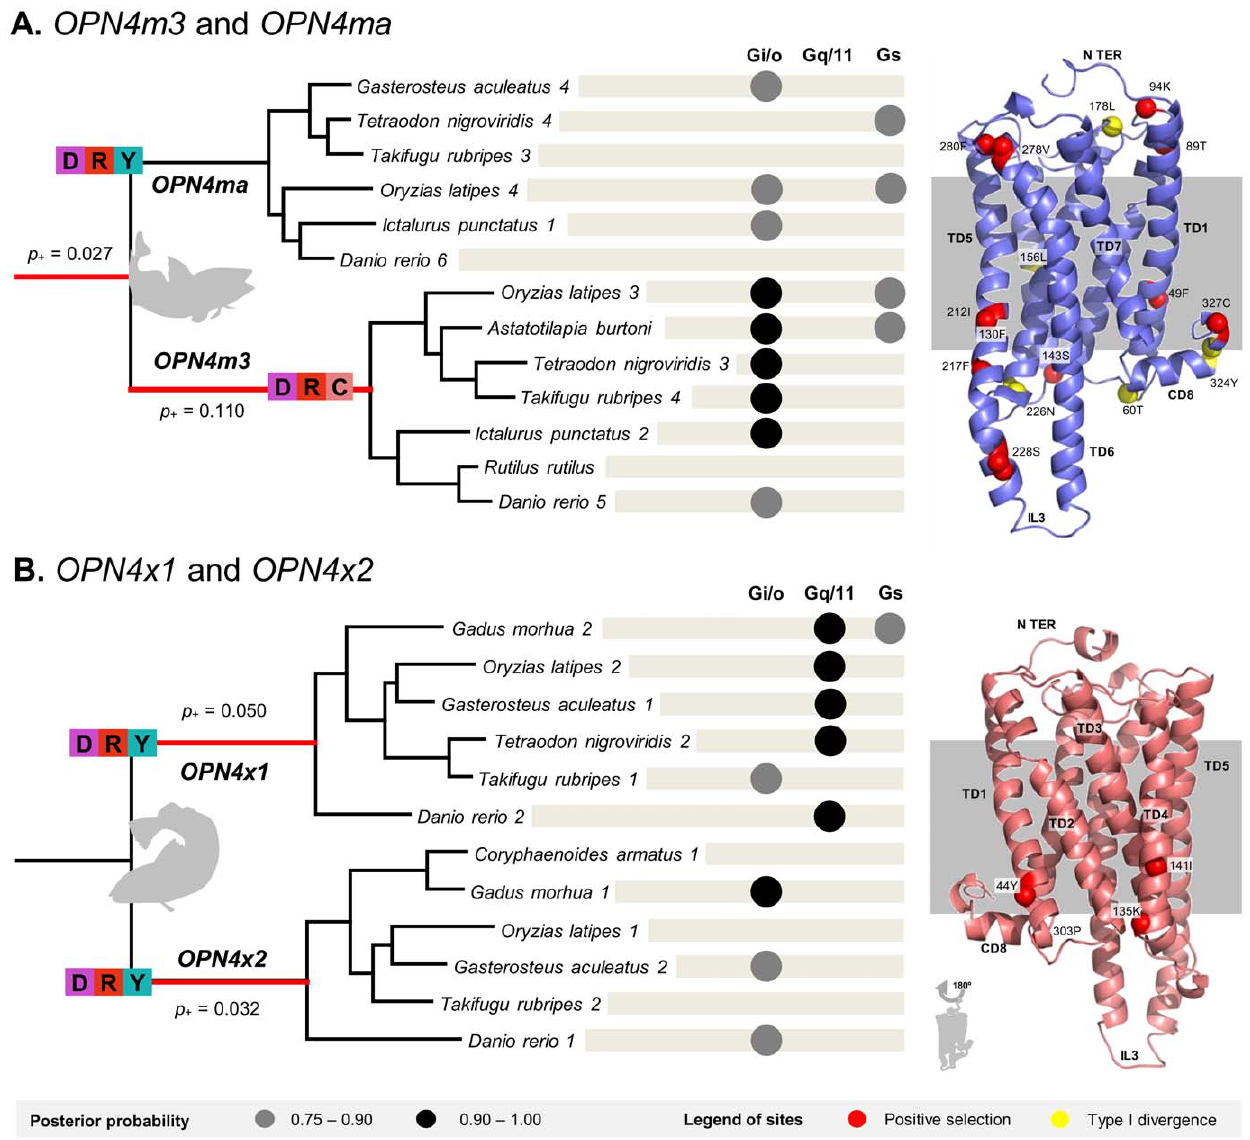
Figure 5. Branch and site selective pressures during the teleost lineage-specific duplications: A. OPN4m3/OPN4ma and B. OPN4x1/ OPN4x2 . A punctual substitution (Y R C) was determined in the DRY motif in the OPN4m3 teleost melanopsin duplicant. Red lineages represent an episode of positive selection and the p + parameter means the proportion of the positively selected sites. Black and grey circles represent the posterior probability level of G-protein coupling preference for each teleost fish amino acid sequence: 0.75–0.90 (grey circles) and . 0.90 (black circles). The three-dimensional structure of the Gallus gallus OPN4m and OPN4x paralogs is also represented showing the occurrence of positive selection and functional divergence at the site